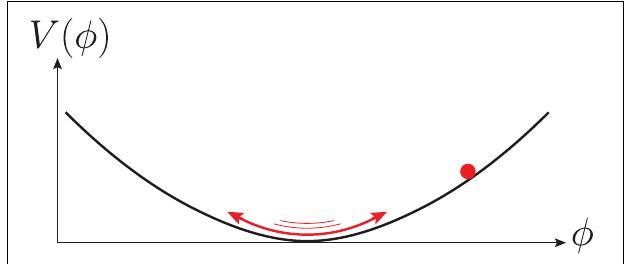
FIGURE 2 | After t 1 , the BCM potential of (cid:2) φ (cid:3) at the red bullet oscillates around the minimum.